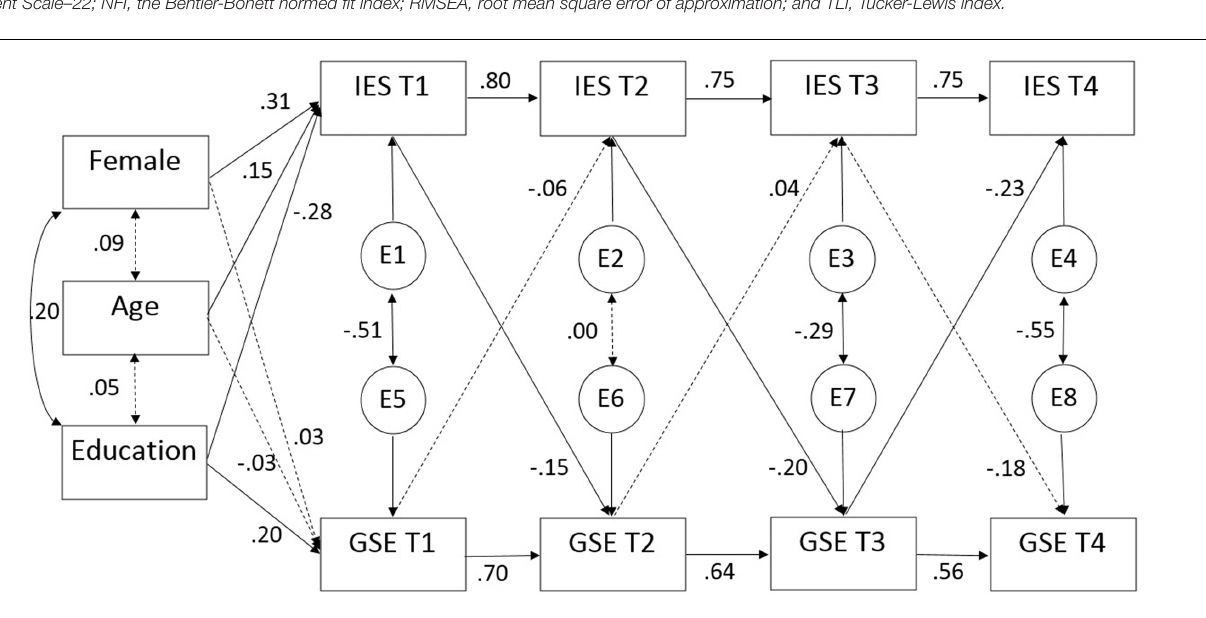
FIGURE 3 | Cross-lagged SEM analyses of posttraumatic stress symptoms and self-efficacy across time. Autoregressive cross-lagged SEM analyses with standardized regression weights across four time points. Covariates were restricted to covary only with measures at T1. Insignificant relationships are indicated by dotted lines, whereas continuous lines indicate statistically significant ( p < 0.05) relationships. GSE, self-perceived GSE as measured by the Generalized Self-Efficacy Scale; IES, posttraumatic stress symptoms as measured by the Impact of Event